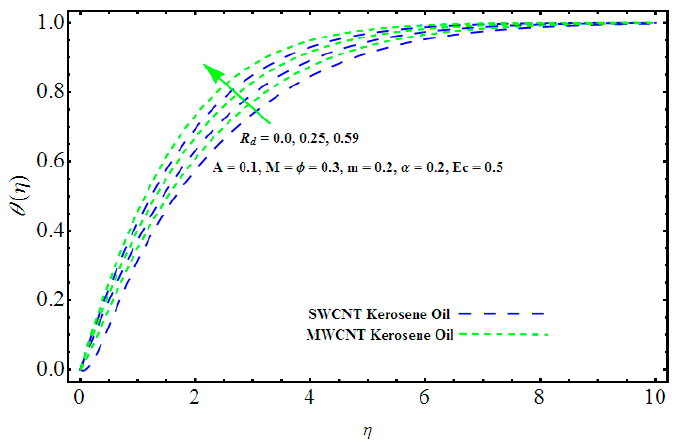
Figure 10. Impact of 𝐸𝑐 on velocity 𝜃(𝜂) .